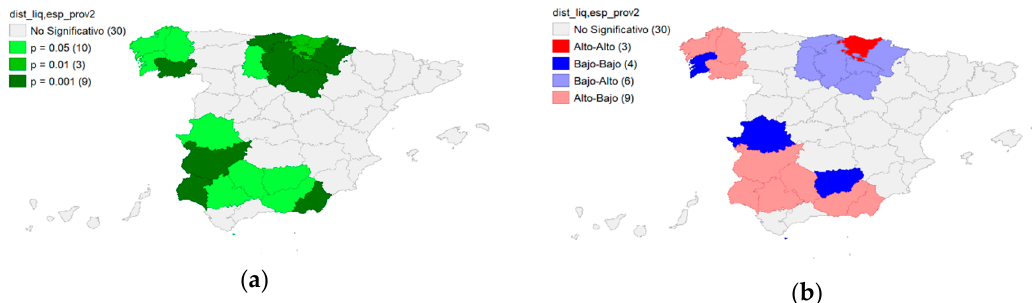
Figure 5. Significance map ( a ) and cluster map ( b ) for Moran’s Local Bivariate Index for liquidation and industrial specialization.